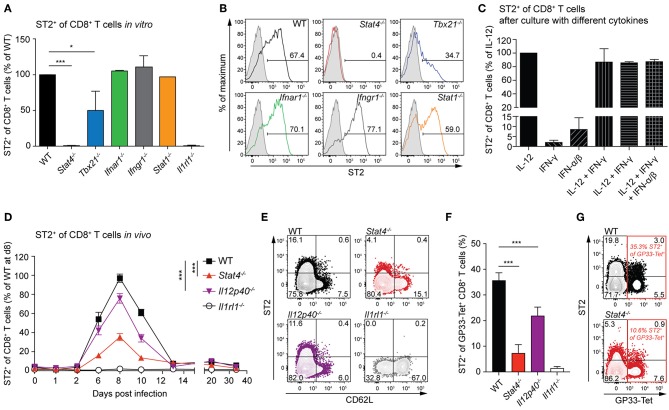
ST2 expression depends largely on STAT4 in CD8+ T cells in vitro and in vivo. (A,B) Naive CD8+ T cells from WT and Stat4−/−, Tbx21−/−, Ifnar1−/−, Ifngr1−/−, Stat1−/−, and Il1rl1−/− mice were activated with soluble anti-CD3 and anti-CD28 plus APCs and differentiated into effector cells in vitro in the presence of IL-12 for 5 days. Mean + SD of ST2 frequency normalized to WT levels (A) in two to three independent cultures and representative histograms of ST2 expression (B) are shown (gray line: Il1rl1−/− control staining). (C) Expression of ST2 on CD8+ T cells after in vitro differentiation with different combinations of cytokines and plate-bound antibodies against CD3 and CD28. Bars indicate the mean + SD of three independent cultures. (D–G) WT, Stat4−/−, Il12p40−/−, and Il1rl1−/− mice were infected with a low dose (LD, 200 PFU) LCMV-WE. (D) Circulating CD8+ T cells were analyzed for ST2 expression. Symbols of the time course analyses represent the mean ± SEM values of two experiments (n = 5 per experiment). P-values were calculated for day 6, 8, and 10 post infection (two-way ANOVA with Bonferroni's post-test). (E) Representative contour plots of ST2 and CD62L expression of CD8+ T cells at day 8 after infection. (F,G) Quantification and representative contour plots of ST2+ GP33-tetramer+ CD8+ T cells on day 8 post infection. Bars indicate the mean + SD (n = 5). P-values were calculated with unpaired two-tailed Student's t-test (A,C,F). *P < 0.05 and ***P < 0.001.